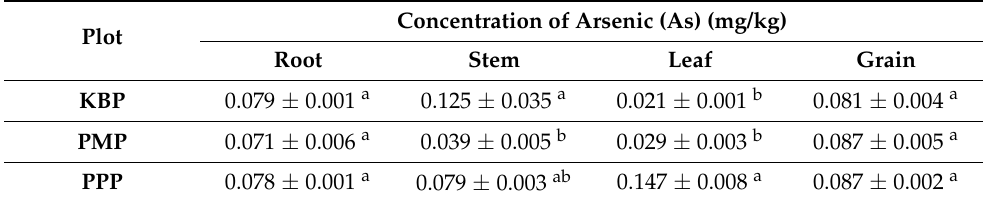
Table 3. Concentration of arsenic in different parts of paddy plants collected from Kelantan. Concentration of Arsenic (As) (mg/kg) Plot Root Stem Leaf Grain KBP 0.079 ± 0.001 a 0.125 ± 0.035 a 0.021 ± 0.001 b 0.081 ± 0.004 a PMP 0.071 ± 0.006 a 0.039 ± 0.005 b 0.029 ± 0.003 b 0.087 ± 0.005 a PPP 0.078 ± 0.001 a 0.079 ± 0.003 ab 0.147 ± 0.008 a 0.087 ± 0.002